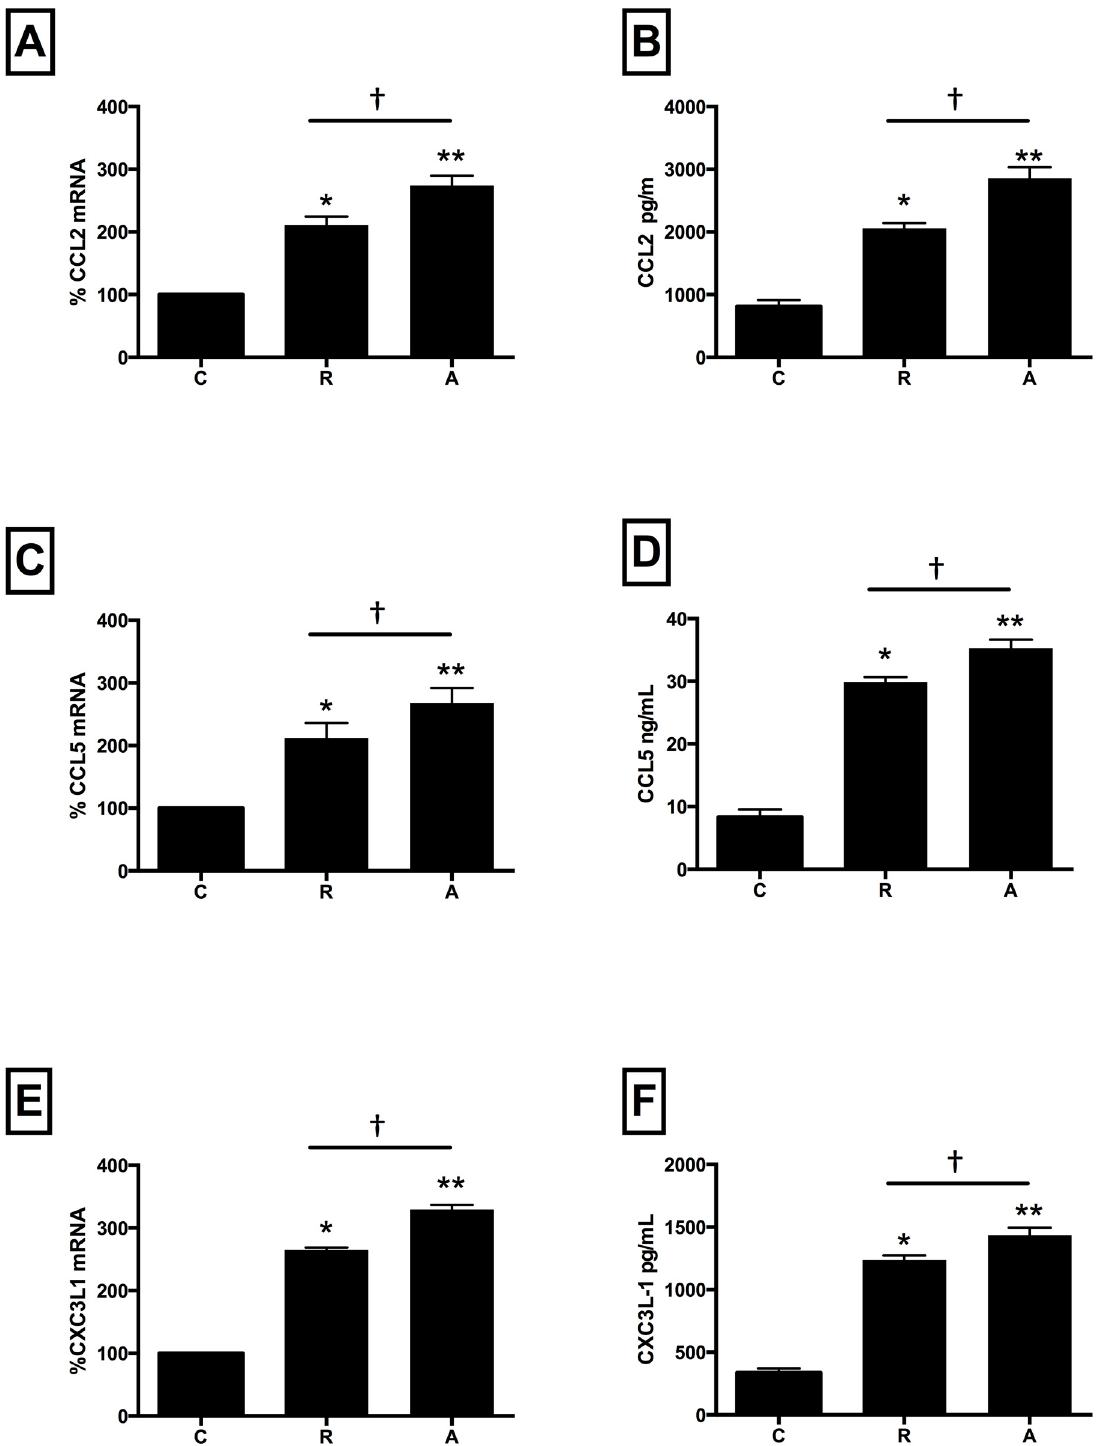
Fig 2. Ranibizumab and aflibercept increase CCL2, CCL5, and CX3CL1 mRNA and protein levels in HCAECs. HCAECs were incubated with ranibizumab (R) (0.11nM) or aflibercept (A) (0.45nM), or PBS (C) for 16 h. Changes in CCL2, CCL-5 and CXC3L1 (panels A, C and E) mRNA levels were quantified using real-time PCR. Protein levels (B, D, F) were quantified using ELISAs. Results are expressed as means +/- SEM. * P < 0.05 ranibizumab treated cells vs. non-treated cells; ** P < 0.05 aflibercept treated cells vs. non-treated cells; † P < 0.05 ranibizumab treated cells vs aflibercept-treated cells.